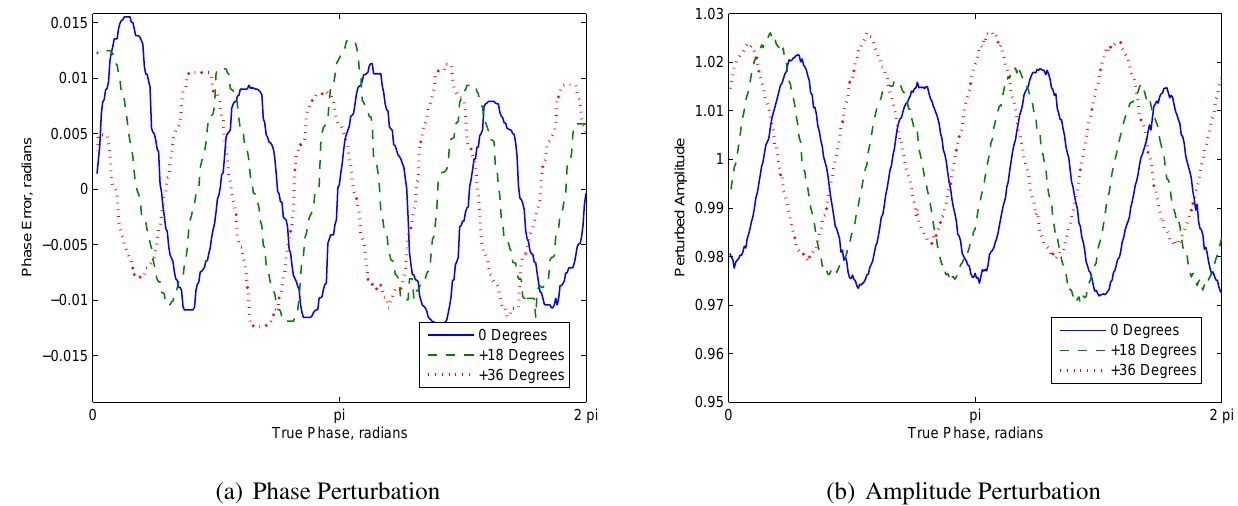
Figure 1. The phase error and amplitude response of a Canesta XZ-422 system operating at 44 MHz with a 50% illumination modulation duty cycle as a function of relative phase of the illumination modulation. The majority of the systematic error is due to aliasing of the positive third